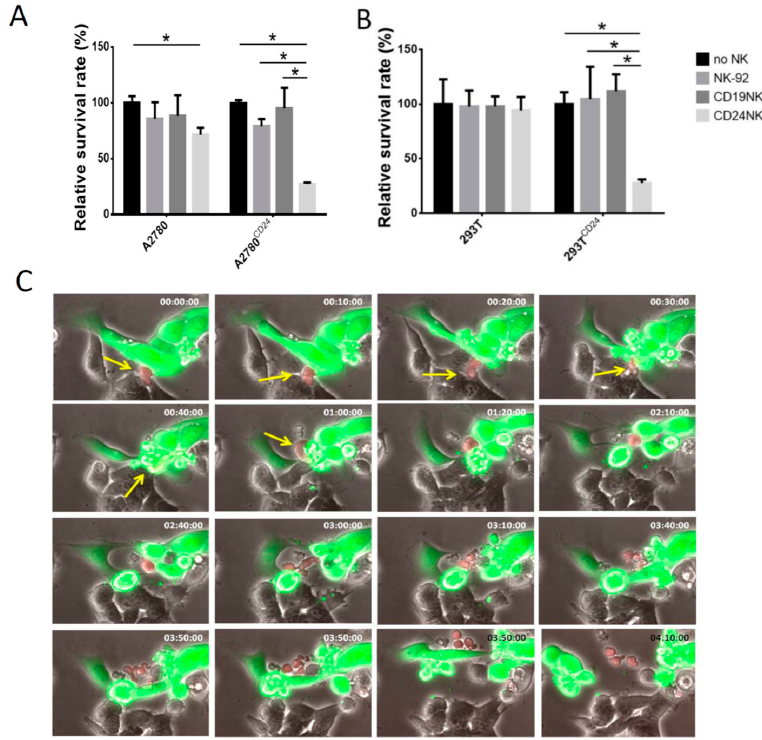
Figure 2. Cytotoxic activity of engineered anti-CD24-CAR-NK-92 cells is restricted to antigen-expressing cells ( A , B ). After lentiviral transduction of A2780 (6.6% CD24 positive) ( A ) and HEK-293T cells (CD24 negative) ( B ), cells were seeded in 96-well plates and co-incubated with the indicated NK cells at an E/T ratio of 5:1. The graphics illustrate the Fluoroskan results after 24 h incubation. * indicate p < 0.05 (unpaired t -test). Values represent the mean from two separate experiments, each containing three samples. ( C) Serial photos of a co-culture of CD24 positive OVCAR3 cells (green) with CD24 negative HEK-293T cells (grey) under the fluorescence microscope. Target cells (OVCAR3 and HEK-293T) were mixed at a ratio of 1:1. Anti-CD24-CAR-NK-92 cells were then added with an E/T ratio of 1:1. Anti-CD24 NK-92 cells (red) specifically kill only CD24 positive OVCAR3 cells and later proliferate. Arrows point to engineered NK-92 cells. Time stamp indicates